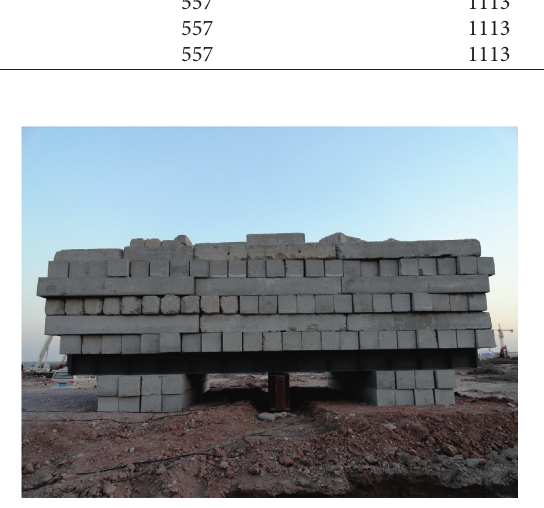
Figure 1: Static load